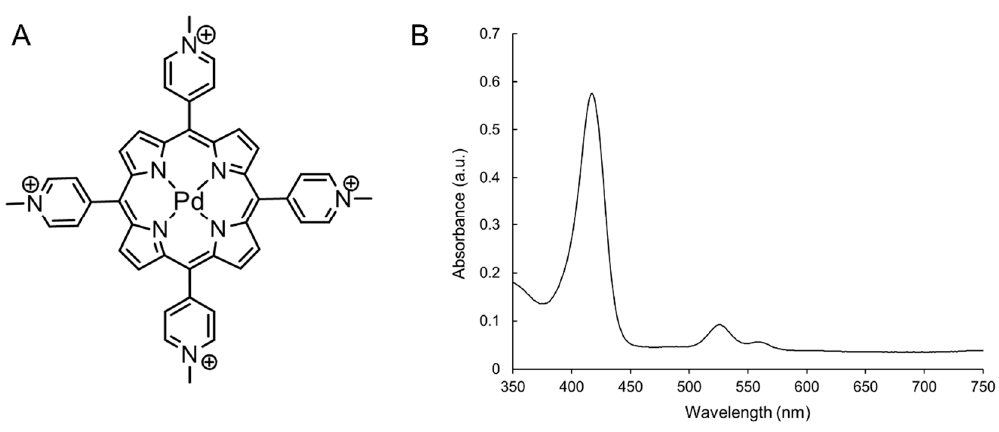
Figure 1. Characteristics of Pd(T4). Structure ( A ) and absorbance spectrum ( B ) of Pd(T4). Higher healthcare costs as well as increased patient stress are associated with clinical treatment times, thus photosensitizer pre-illumination times were assessed. Minimal changes in viability were